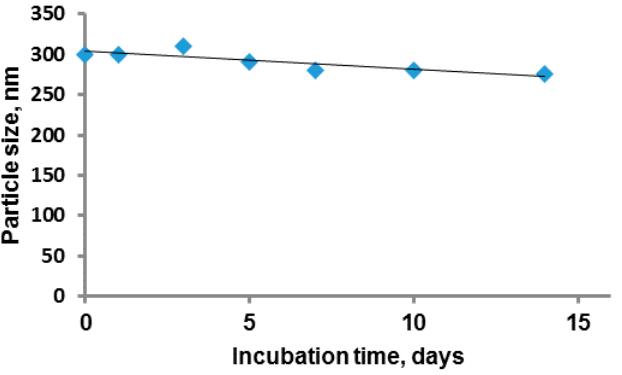
Figure 6. Storage stability of the GP3 colloid system at physiological conditions. Conditions: PBS buffer of pH 7.4; temperature 37 °C; concentration 0.5 mg/mL.